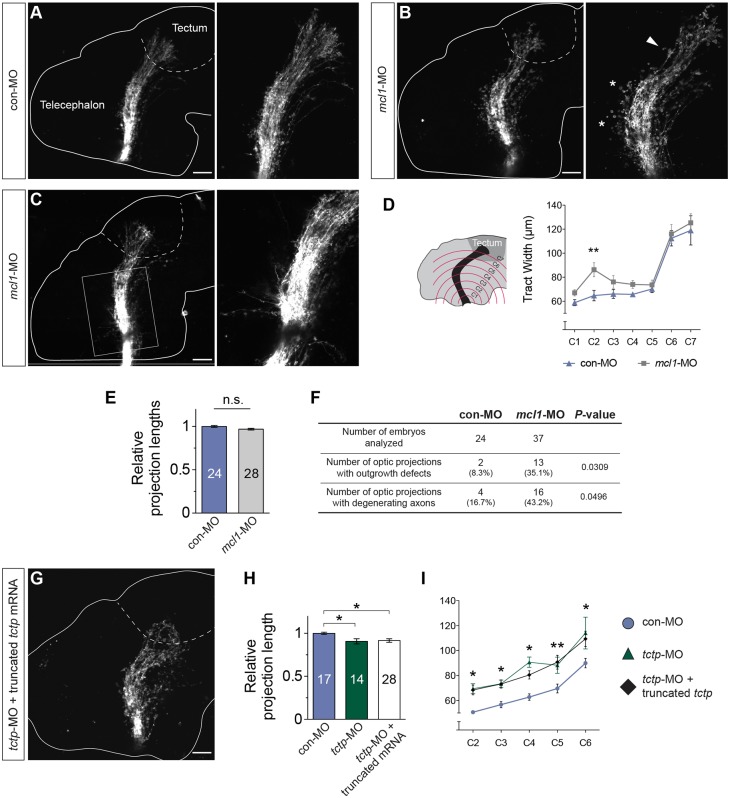
Tctp regulates axon development via its anti-apoptotic effects. (A-C) Lateral view of DiI-filled retinotectal projections in con-MO-injected or mcl1-MO-injected stage 40 embryos. Dashed lines approximate the boundary of the optic tectum; arrowhead denotes a region of the tract with outgrowth defects; asterisks mark beaded axons, suggestive of degenerating axons; boxed region in C shows axon misprojections into the telencephalon and diencephalon. Panels to the right show enlarged images. The boxed area in C is centred in the ventral optic tract. (D) Mean (±s.e.m.) optic tract width in con-MO-injected and mcl1-MO-injected embryos. C2, **P<0.01, two-way ANOVA. C2-7 denote imaginary, evenly spaced hemi-circumferences centred on the optic chiasm. (E) Relative projection lengths in control and Mcl1 morphant backgrounds. Mean±s.e.m.; n, number of brains analysed; n.s., not significant; Mann–Whitney test. (F) Summary of phenotypic changes in Mcl1 morphant projections (statistical significance determined using Fisher's exact test). (G) Co-delivery of tctp-MO and tctp40-172 mRNA, which encodes a truncated Tctp protein devoid of anti-apoptotic activity, fails to rescue the effects of Tctp depletion on the development of the retinotectal projection. (H) Relative projection lengths in embryos injected with con-MO, tctp-MO or tctp-MO+truncated tctp40-172 mRNA. Mean±s.e.m.; n, number of brains analysed; *P=0.008, Kruskal–Wallis test. (I) Mean (±s.e.m.) optic tract widths. con-MO versus tctp-MO+truncated tctp40-172 mRNA, *P<0.05 (C2), *P<0.05 (C3), *P<0.05 (C4), **P<0.01 (C5), *P<0.05 (C6), two-way ANOVA with Bonferroni correction. Scale bars: 50 μm.